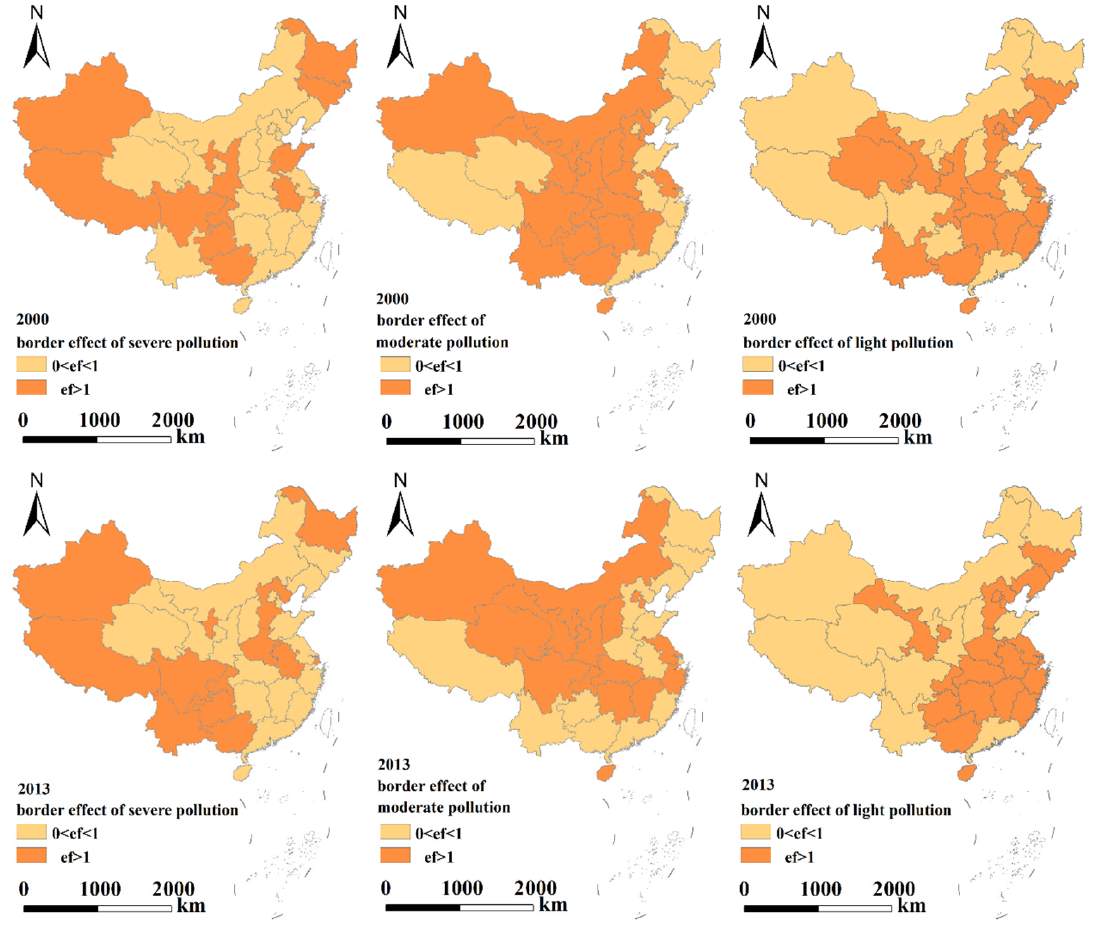
Figure 2. Transboundary pollution effects at the provincial level (all types of polluting enterprises).